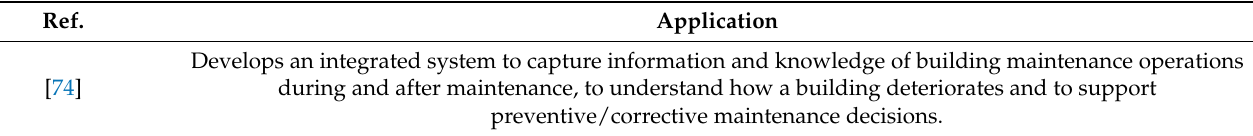
Table 3. Recent DTs-based applications in the AECO